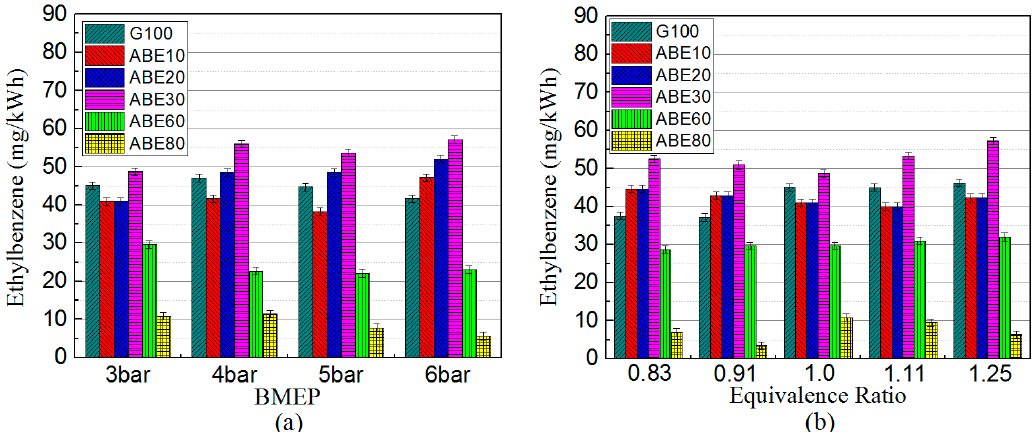
Figure 9. Ethylbenzene emissions at ( a ) stoichiometric conditions under different BMEP, and at ( b ) 3 bar BMEP under different equivalence ratios. Energies 2018 , 11 , x FOR PEER REVIEW